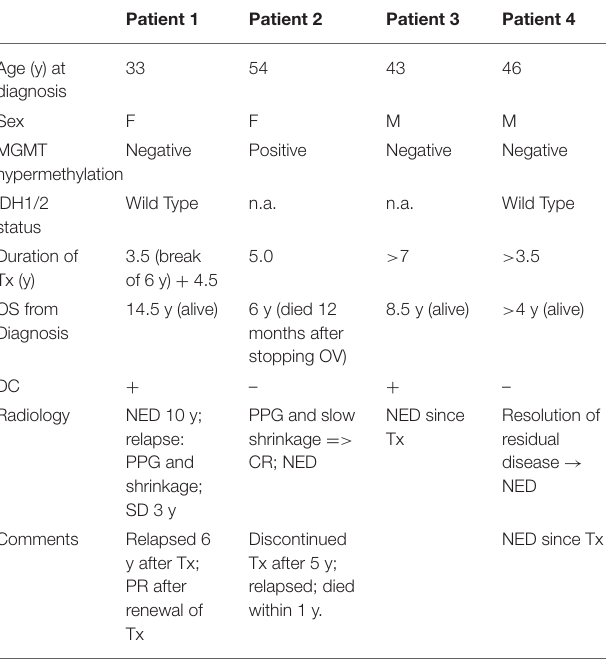
TABLE 1 | Clinical summary of GBM patients undergoing OV